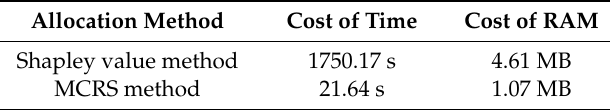
Table 7. Comparations in computational